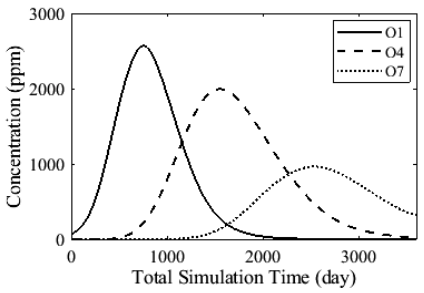
Figure 4. Concentration curves in the sampling locations O 1 , O 4 and O 7 .